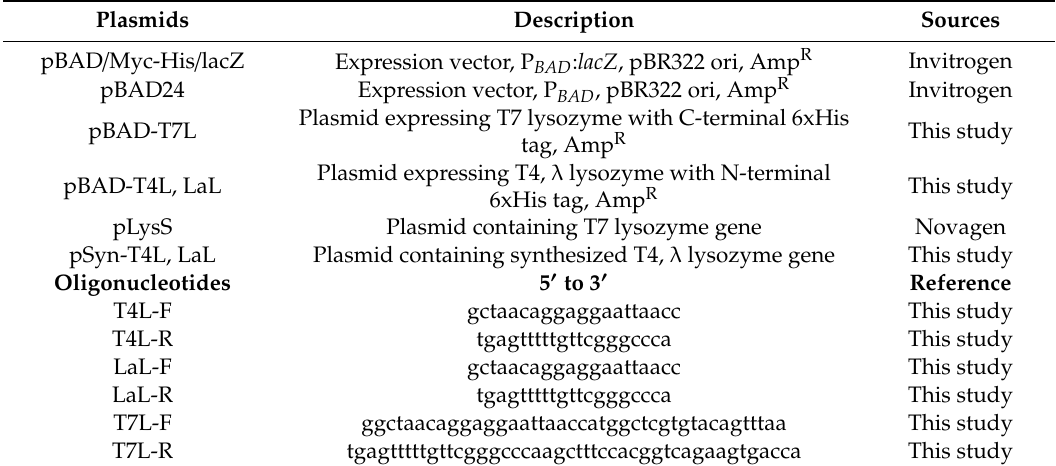
Table 1. Plasmids and oligonucleotide sequences used in this study. Plasmids Description Sources Expression vector, P BAD : lacZ , pBR322 ori, Amp R